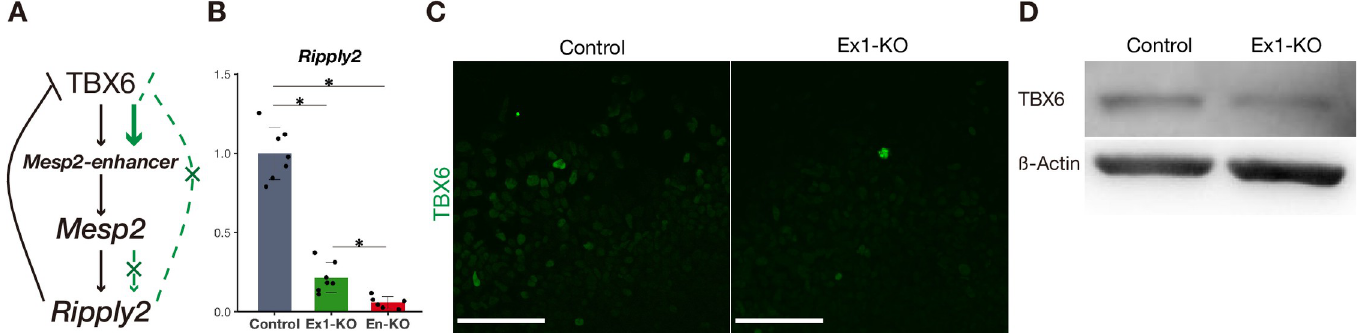
Fig 3. The negative feedback loop does not function properly in the in vitro PSM system. A Schematic diagram of reciprocal regulation of Mesp2 . Green lines and characters indicate the process of Mesp2 disruption. B qPCR analysis of Ripply2 in in vitro PSM (n = 6 or 7 cultures for each genotype). The expression level is presented as the ratio against iTbx6;iNICD line (control). P -values were calculated by the Mann-Whitney U test comparing iTbx6;iNICD (control) and iTbx6;iNICD ; Mesp2 -Exon1-KO or iTbx6;iNICD ;P2-Enhancer-KO, or comparing iTbx6;iNICD ; Mesp2 -Exon1-KO and iTbx6;iNICD ;P2-Enhancer-KO. Data are presented as the mean ± SD. Asterisk indicates significant ( p < 0.05). C Immunostaining of TBX6 in the in vitro PSM of iTbx6;iNICD (control) (left) and iTbx6;iNICD ; Mesp 2-Exon1-KO (right) upon Dox administration. Scale bars: 100 μ m. D Western blotting analysis to monitor the degradation of TBX6 in the in vitro PSM of iTbx6;iNICD (control), and iTbx6;iNICD ; Mesp2 -Exon1-KO upon Dox administration. ß-Actin was used as the internal control of the protein lysate.